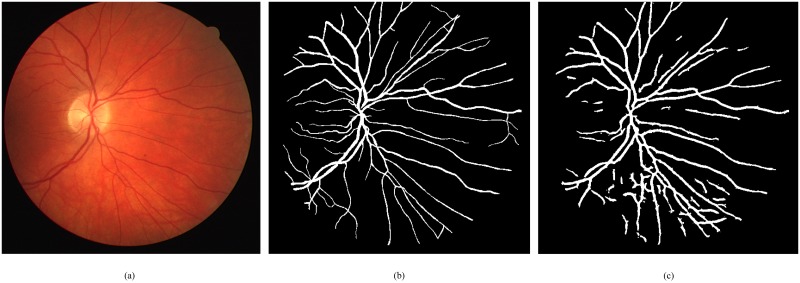
Pictorial representation for unhealthy retinal image from the DRIVE dataset.(a) RGB image (b) Manual segmentation (c) Proposed scheme final result.